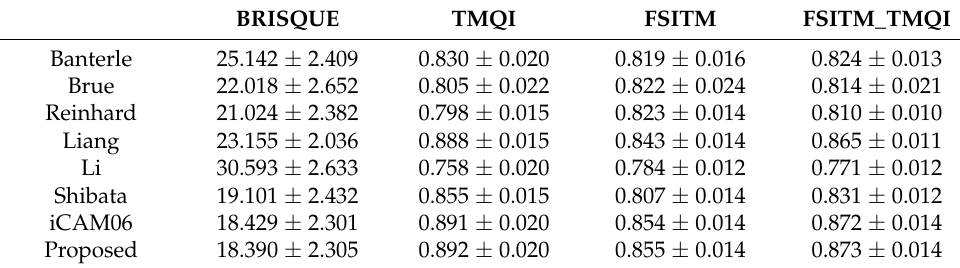
Table 1. Comparison of image quality assessment